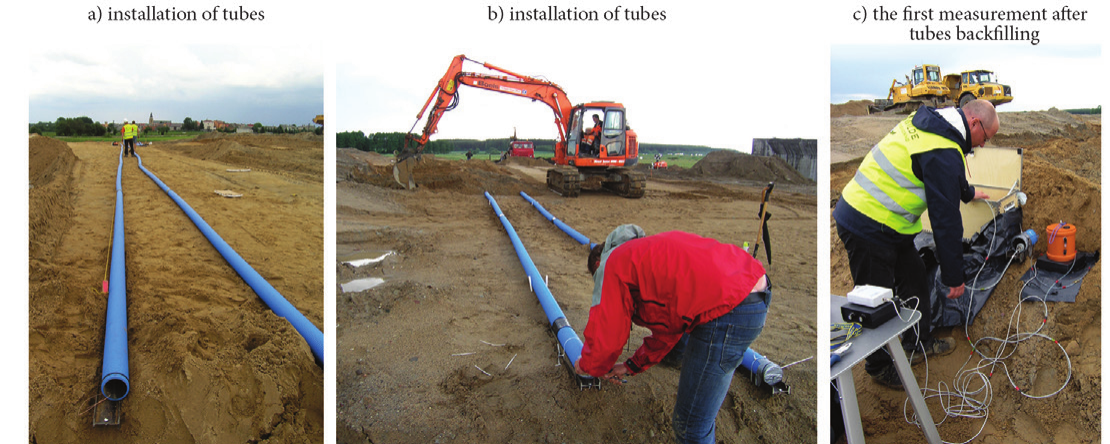
Fig. 8. Embankment settlement measurement by hydrostatic levelling